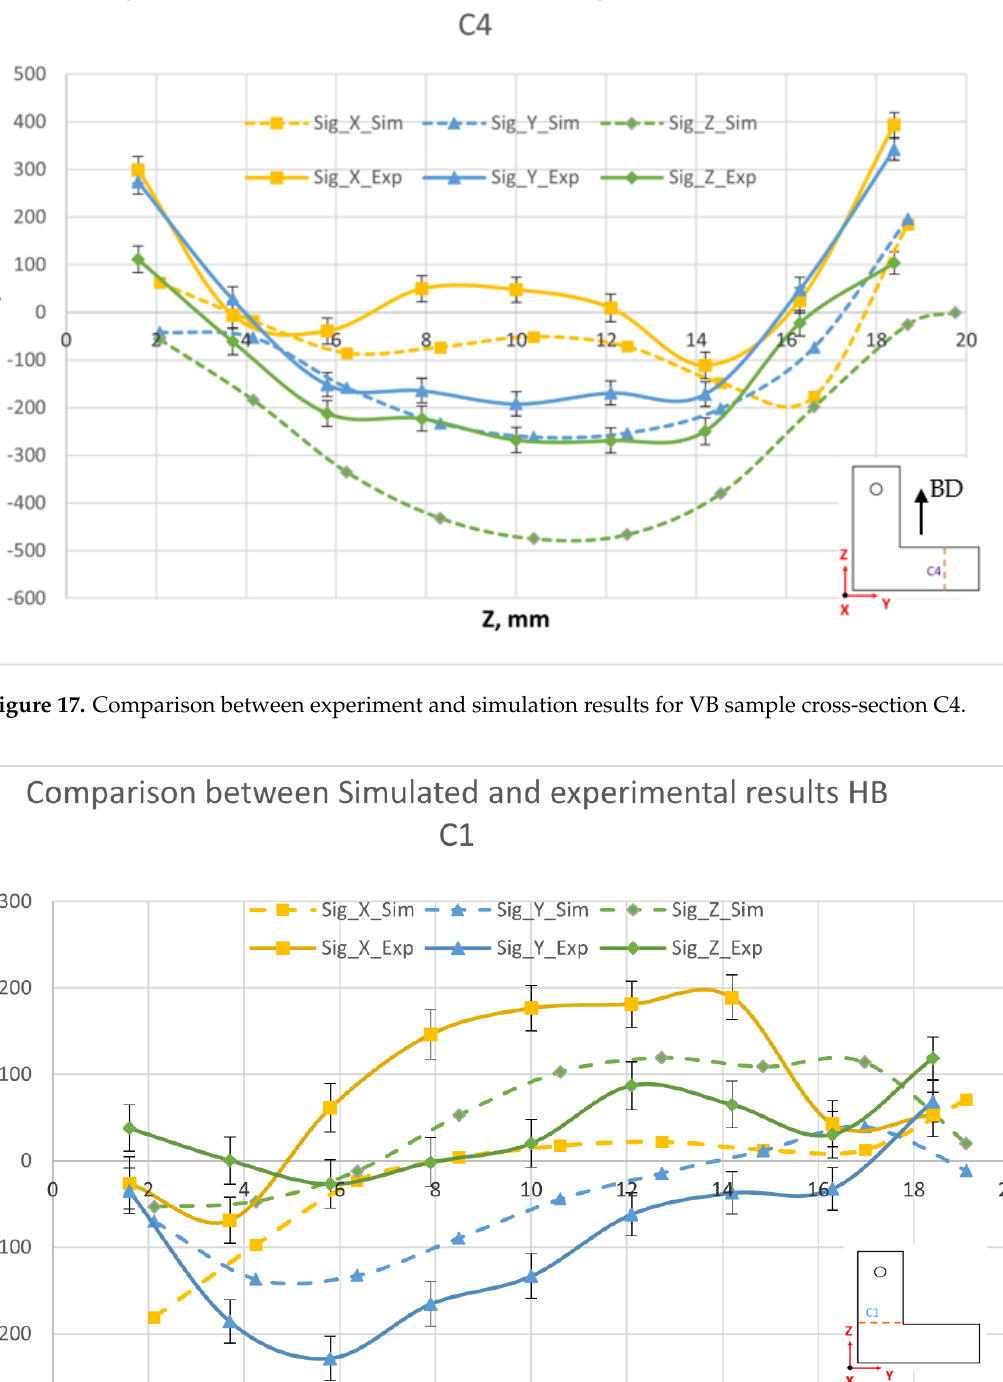
Figure 16. Comparison between experiment and simulation results for VB sample cross-section C3.